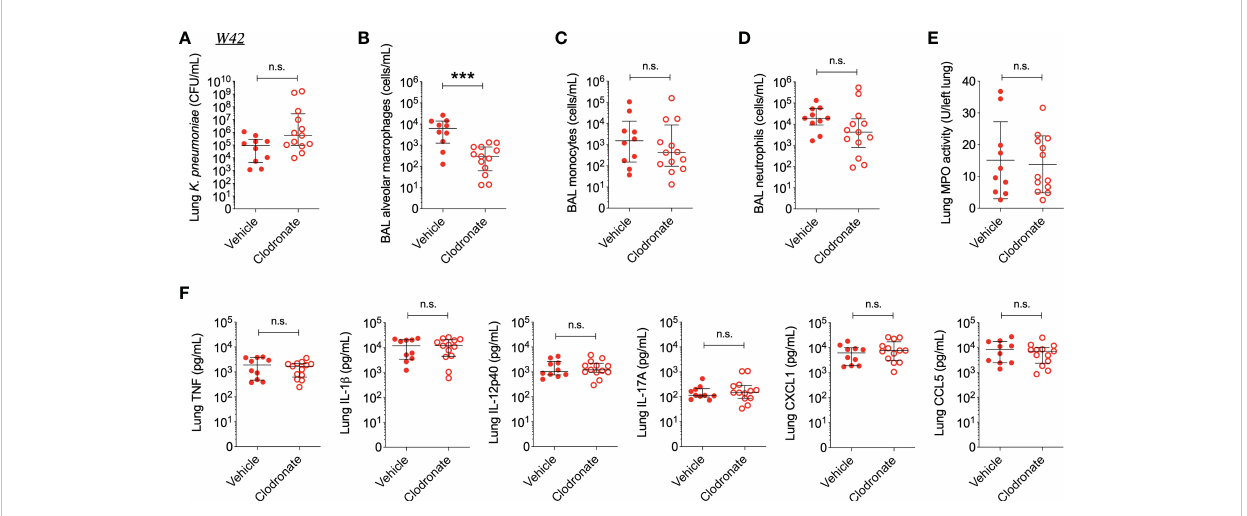
FIGURE 4 Alveolar macrophage depletion with clodronate does not affect bacterial burden and in fl ammation in mice infected with the phagocytosis-resistant W42 isolate. (A) CFU of Kp in lung homogenates obtained from C57BL/6J mice treated with clodronate (N=13, intratracheal, 0.5mg/mouse) or empty liposomes (N=10) and subsequently infected with W42 Phago-Res (inoculum: 10 3 CFU) for 24 hours. (B) Numbers of alveolar macrophages, (C) monocytes, and (D) neutrophils in BAL specimens from W42-infected mice treated with clodronate or vehicle, as determined by fl ow cytometry. (E) MPO activity in lung tissue homogenates from W42-infected mice treated with clodronate or vehicle. (F) Levels of TNF, IL-1 b , IL-12p40, IL-17A CXCL1, and CCL5 in lung tissue homogenates from W42-infected mice as determined by ELISA. Data represent medians ± interquartile range (A – D, F) or means ± SD (E) + individual data points. ***p<0.001, n.s.: not signi fi cant (A – D, F) : Mann-Whitney test; (E) : t test with Welch ’ s